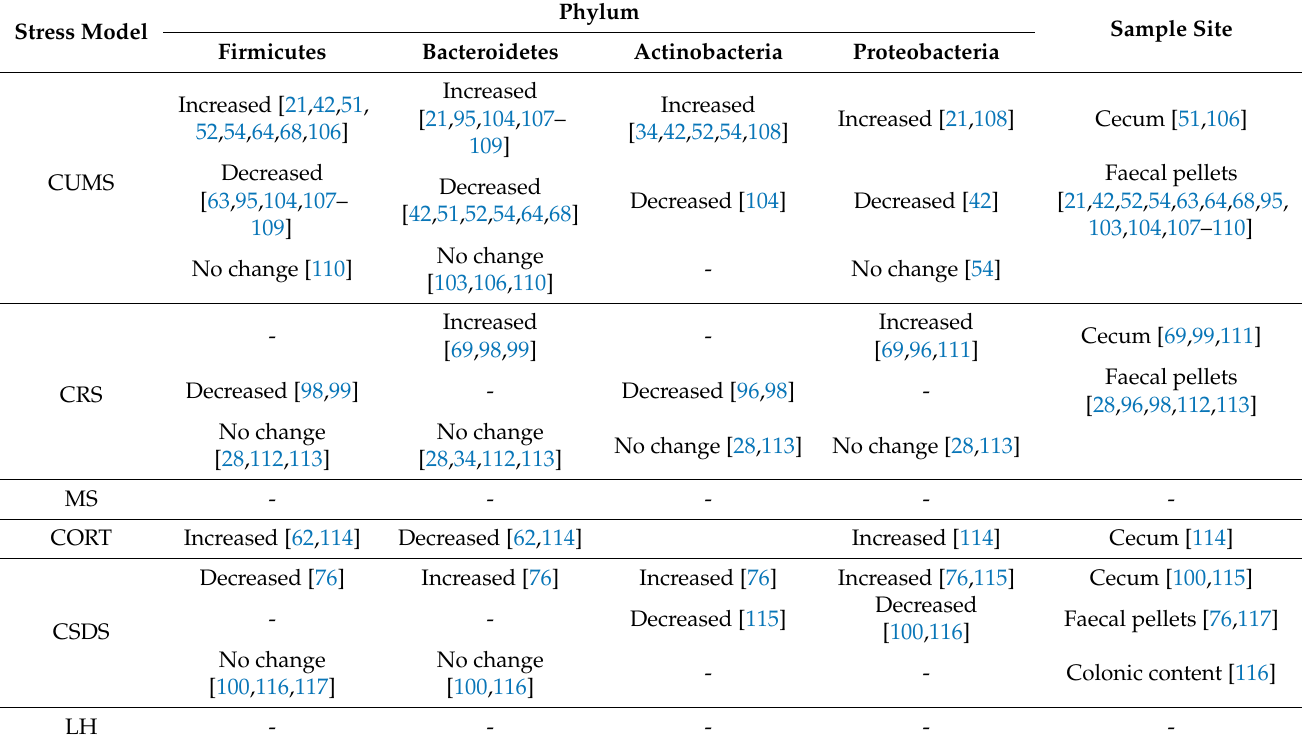
Table 1. The effects of stress on gut and brain pathology and behaviour in male animal models of stress and